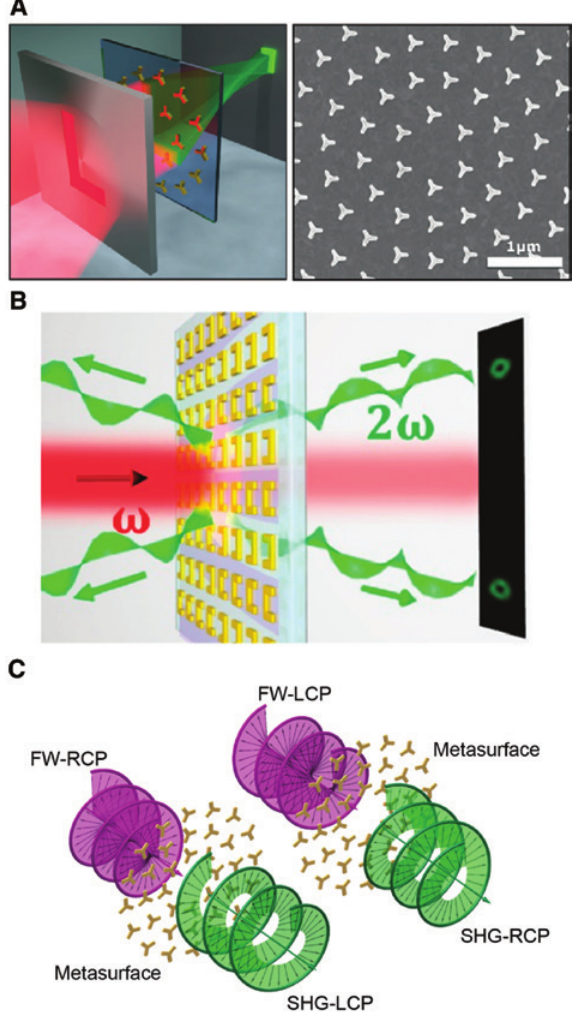
Figure 5: Metasurface for nonlinear imaging and wavefront